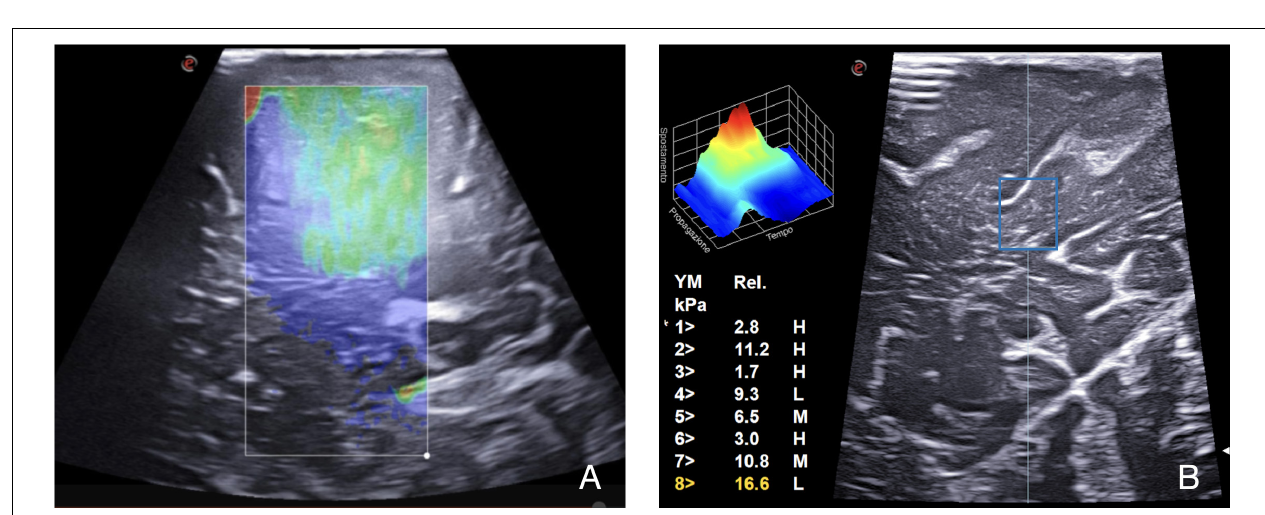
FIGURE 3 | Navigated MIP-CEUS. (A) On the left, a real-time MIP-CEUS sequence is displayed; (B) on the right, the corresponding pre-operative MRI is fused with real-time ioUS. The signal obtained throughout the MBs distribution can be depicted in a MIP image to describe the entire vascular-tree including smaller vessels under structural and functional aspects, giving detailed representation of the CE pattern.